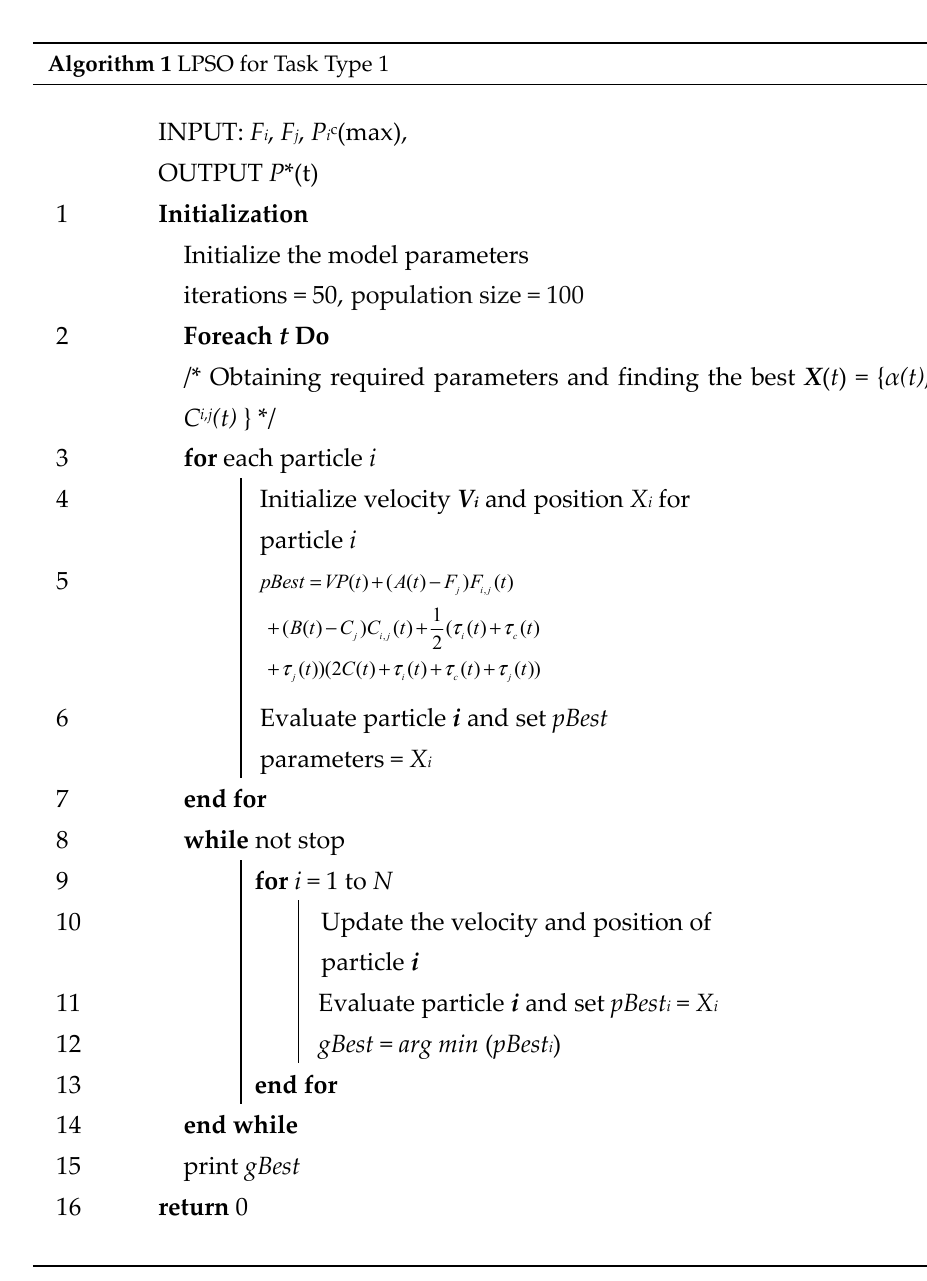
Algorithm 1 LPSO for Task Type 1